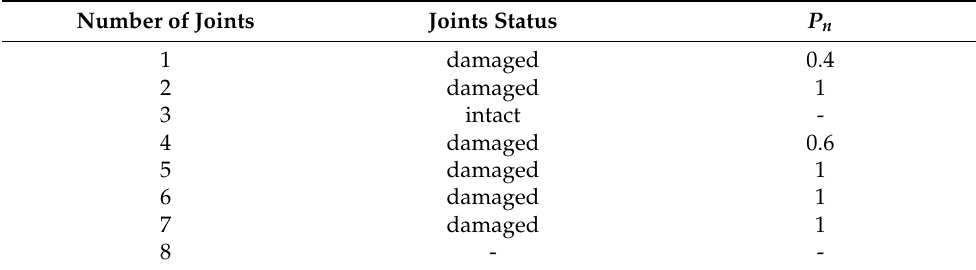
Table 4. P n values of an ARHB bridge with 9 beams. Number of Joints Joints Status P